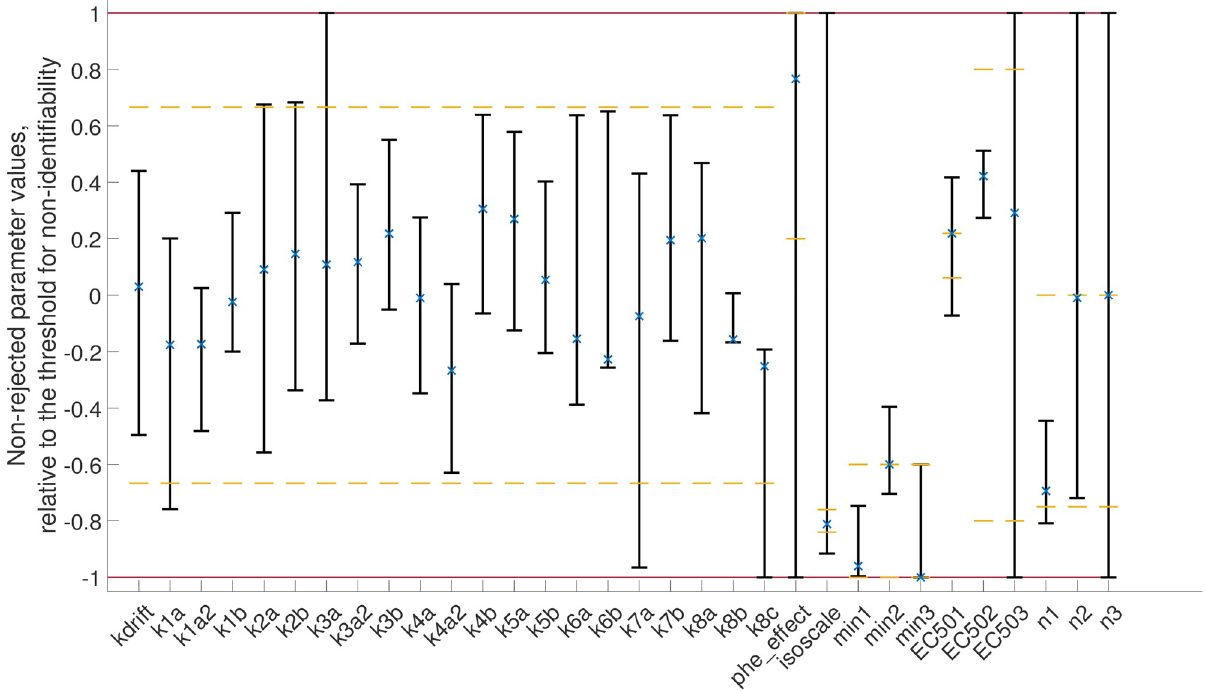
Fig 2. Parameter identifiability analysis. The minimal and maximal values of a parameter was found using the optimization approach detailed in the Methods—Uncertainty estimation section. The parameter values are expressed as relative values with respect to threshold for non-identifiability, where -1 represents a parameter value at the lower threshold, and 1 represents a parameter at the upper threshold. x represent the optimal parameter values and yellow dashed lines represent the bounds for a specific parameter when estimating parameter values. The thresholds for identifiability, and maximal and minimal values for the parameter values are given in S1 Table. The bounds on the parameter values and the values of the optimal parameter found during in the parameter estimation is given in S2 Table.